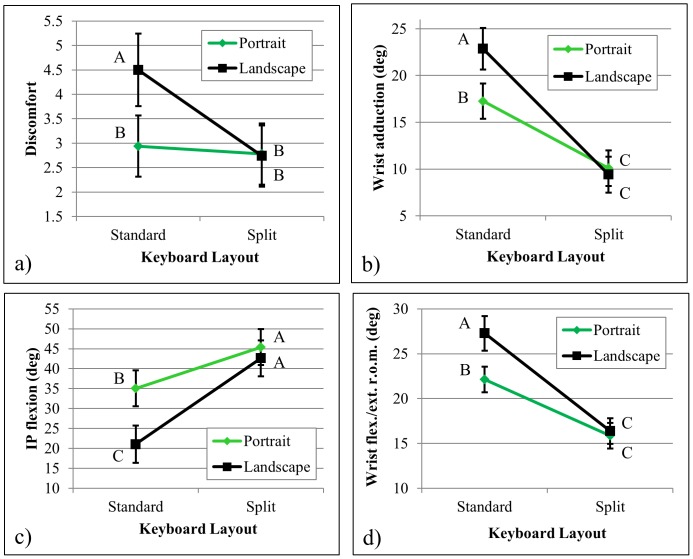
Significant interaction effects between Keyboard Layout and Device Orientation.Least squares (and standard error) values are presented for (a) mean self-reported discomfort across device orientation and keyboard layout, (b) median wrist adduction across device orientation and keyboard layout, (c) median IP flexion across device orientation and keyboard layout, and (d) wrist joint range of motion for the flex./ext. axis across device orientation and keyboard layout. The superscript letters in the figure represent results from the Tukey post-hoc analysis: same letters denote groups without significant differences. Values with different letters are ranked such that A>B>C.